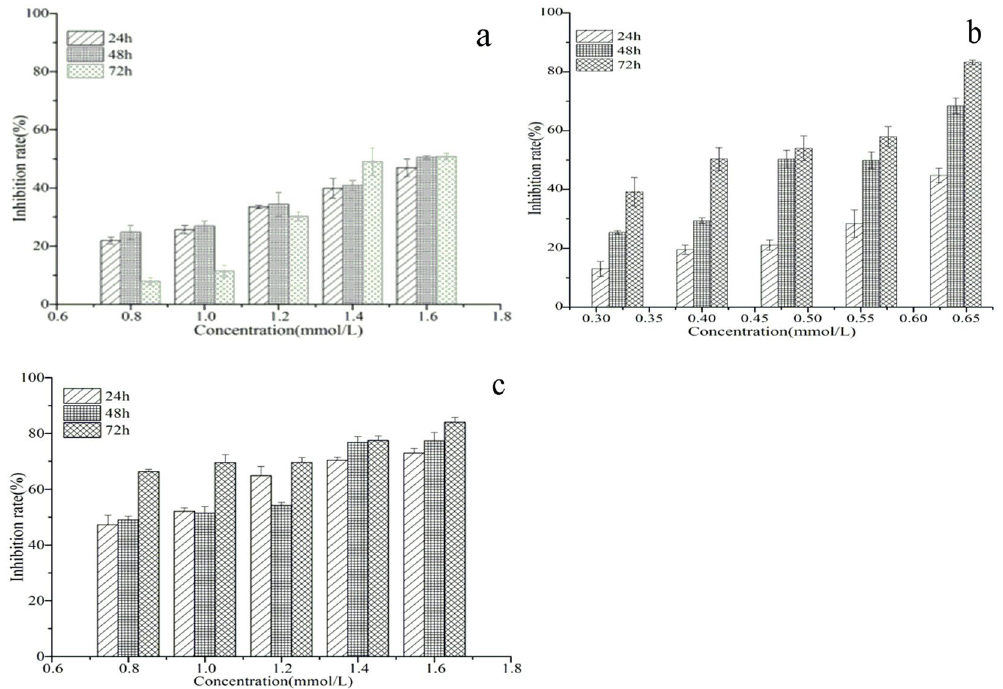
Figure 10. Inhibition rate of Hela229 cells after treatment with matrine ( a ), matrine derivative 1 ( b ) and matrine derivative 2 ( c ). All data represented are mean ± S.E.M. from three independent experiments.